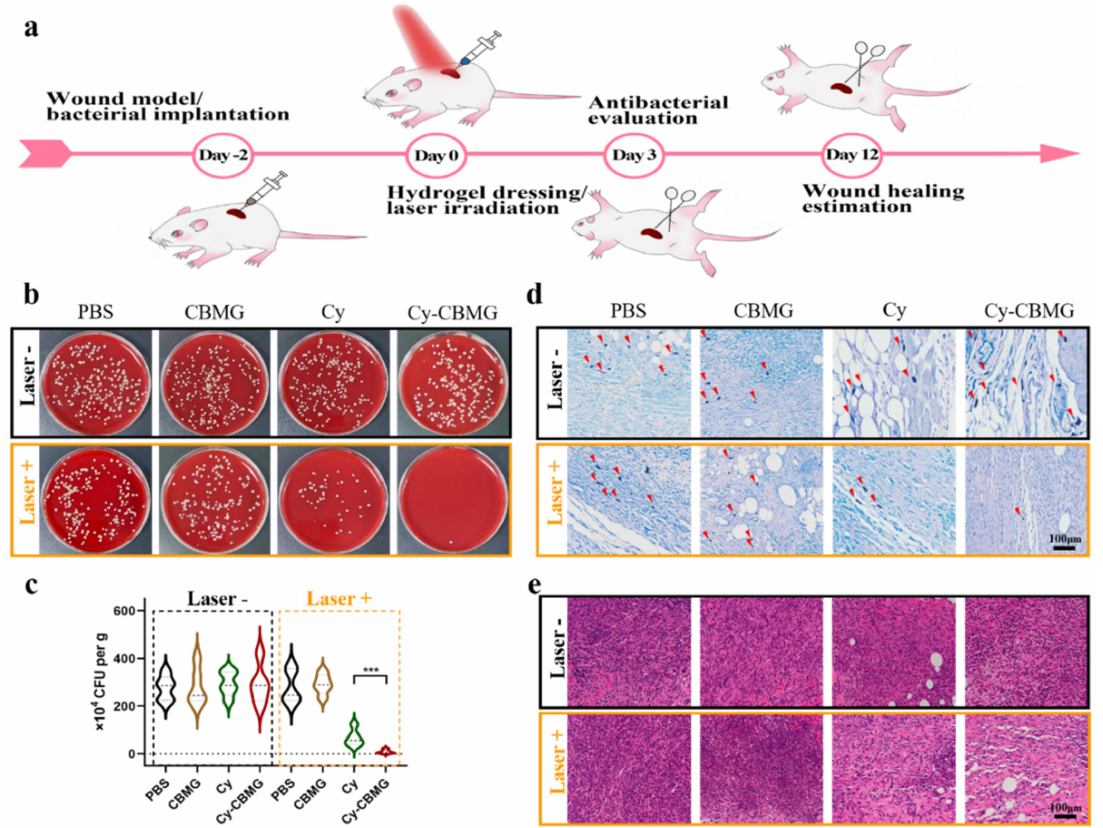
Figure 5. Antibacterial activity and anti-inflammation in vivo. ( a ) Schematic drawing of the workflow for in vivo experiments. A skin wound was created and MRSA were implanted. Treatments and laser irradiation were given 2 days later. ( b ) Representative CFUs in wound tissues after retreated with PBS, CBMG, Cy and Cy-CBMG with or without laser irradiation exposure (600 nm, 100 mW/cm 2 ). ( c ) Analysis of bacterial viability according to CFUs in wound tissues. ( d ) Representative Giemsa- stained wound tissues. Red arrow indicated bacterial load in wound tissues. ( e ) Representative H&E staining of the wound tissues. ***: a statistically significant difference between groups, p <